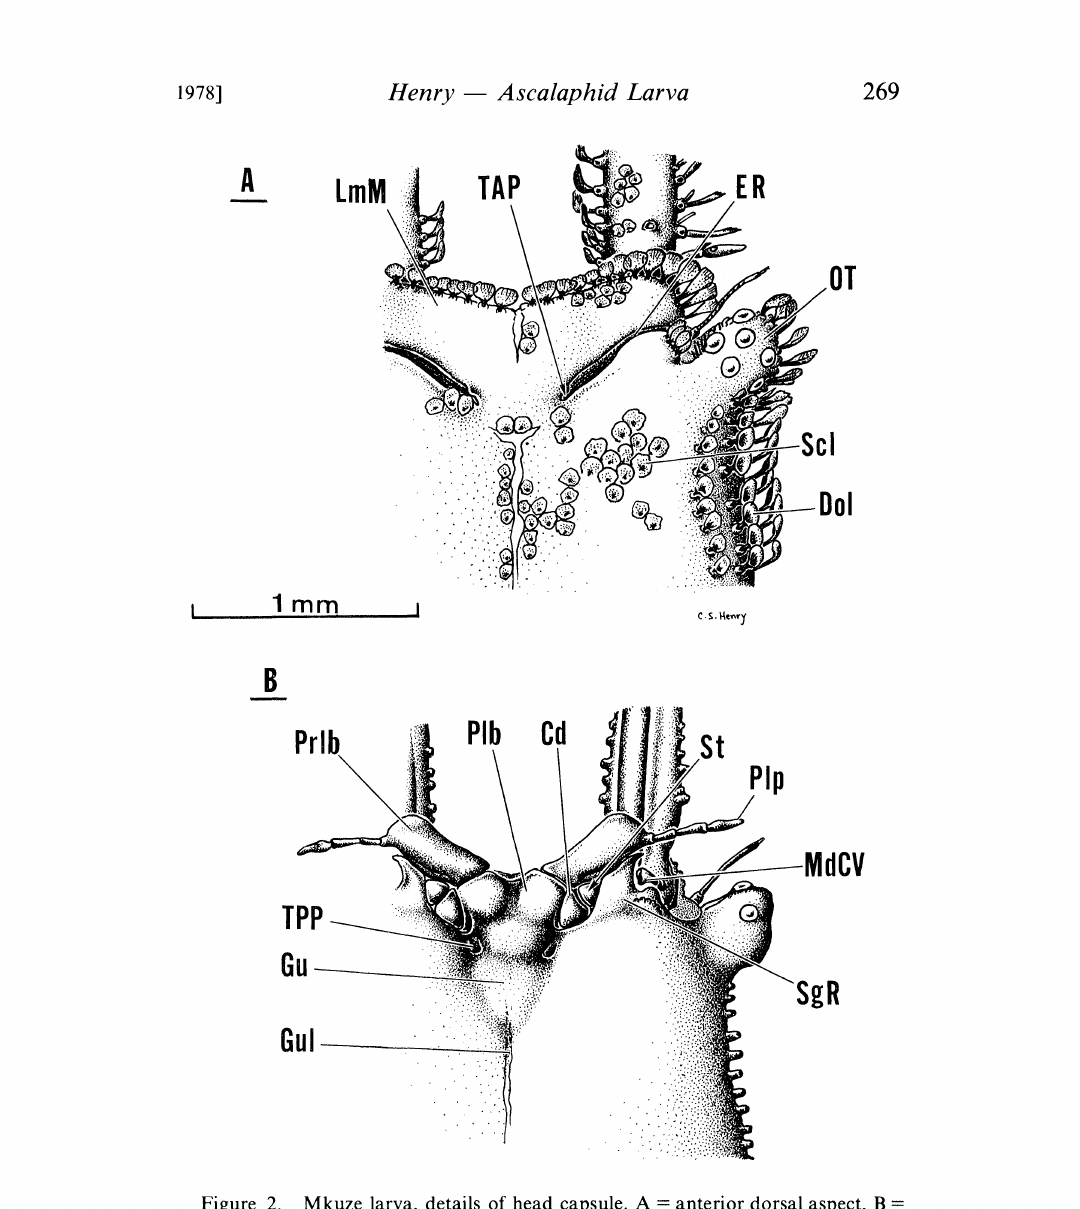
Figure 2. Mkuze larva, details of head capsule.